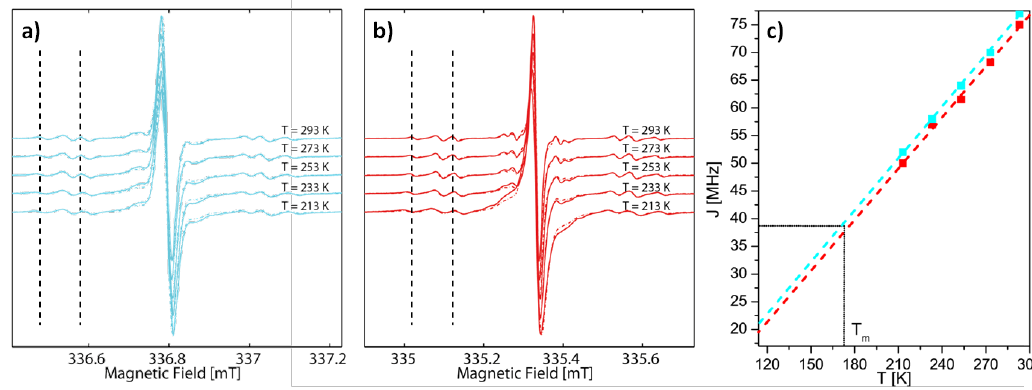
Figure 5. CW X-band EPR spectra of: ( a ) 4a •• ; and ( b ) 4b •• in liquid solution at different temperatures. The vertical dashed lines are meant to visualize the temperature-dependent shift of the satellite lines. The full lines are the experimental and the underlying dotted ones the simulated spectra. The dependence of the magnitude of J on the temperature is shown for 4a •• (cyan) and 4b •• (red) ( c ). The lower bound of the T axis is equal to T g of the solvent system, T m is indicated in the graph.